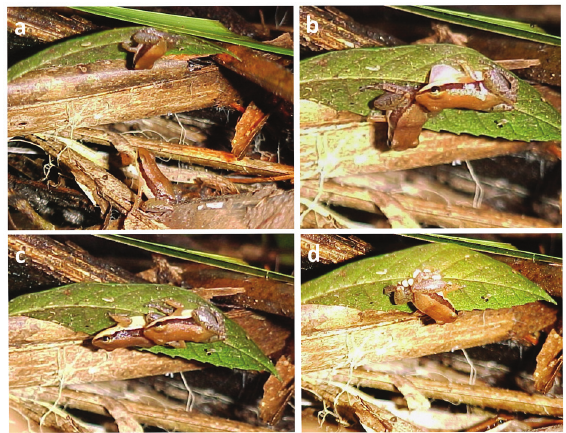
Figure 4 - Courtship, mating and oviposition behavior of Allobates subfolionidificans . ( a ) Female on the ground before jumping and male adhered to the underside of a leaf. ( b ) Male and female adhered to the underside of a leaf. ( c ) Mating couple. ( d ) Female upside down performing oviposition.